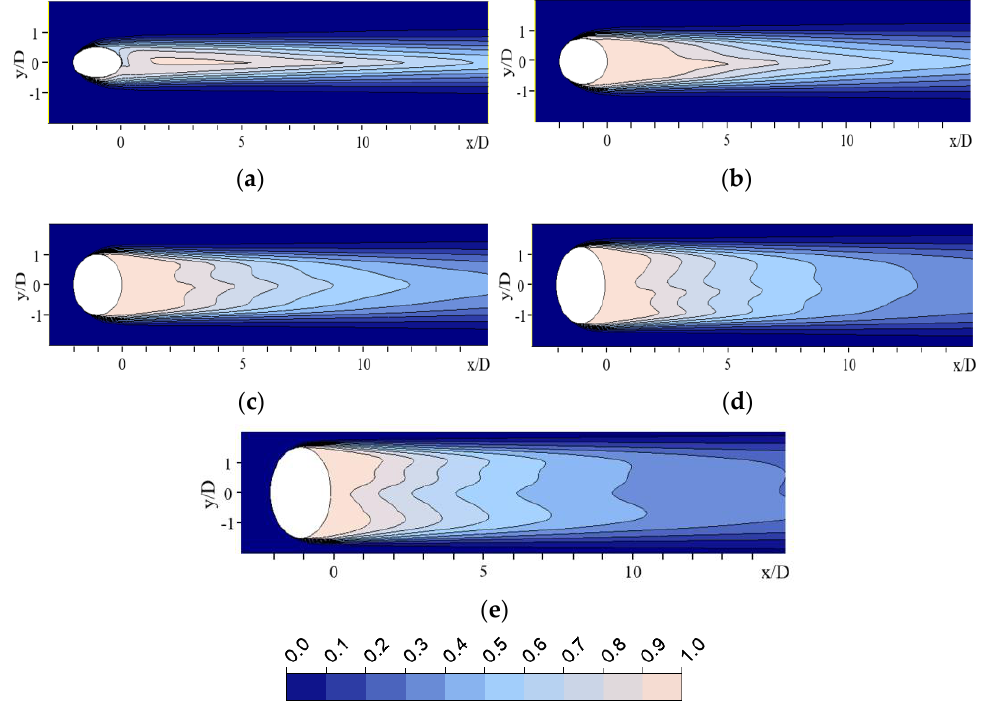
Figure 20. FE distributions on the x-y plane at z/D = 0: ( a ) reference, ( b ) S2 = 1.5D, ( c ) S2 = 2D, ( d ) S2 = 2.5D, ( e ) S2 = 3D. ( d ) S2 = 2.5D, ( e ) S2 =